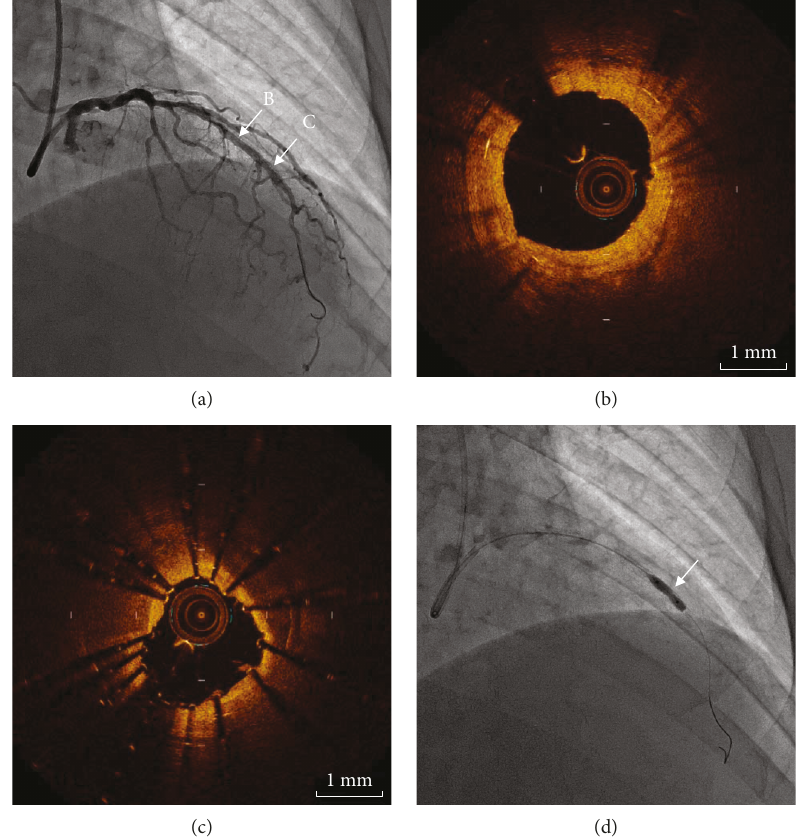
Figure 2: Coronary angiography and corresponding OCT image after PCB and DES implantation. (a) Angiography showed residual stenosis at the newly stented site. (b) OCT image of the lesion treated with PCB. (c) Ununiformed dilatation of newly implanted DES and dilation failure of calci fi ed neointima. (d) Postdilatation with noncompliant balloon. White arrow: balloon indentation. OCT: optical coherence tomography, PCB: paclitaxel-coated balloon, DES: drug-eluting